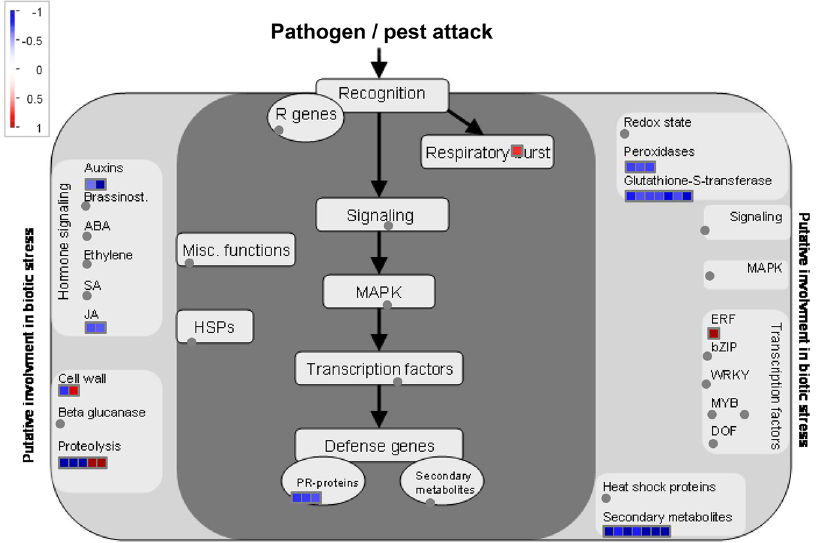
Figure 6. Visualization of biotic stress pathways in wheat differentially expressed genes (DEGs) by MapMan. Thirty-three data points showing putative involvement in biotic stress were mapped for 29 DEGs of wheat (see detailed information on the genes in Supplementary Table S6). Red and blue dots represent the genes that were up- and down-regulated in wheat roots when they were exposed to nematodes compared to the control (wheat roots without contact with the juvenile nematodes), respectively. The magnitude of the change in gene expression is associated with deepness of the